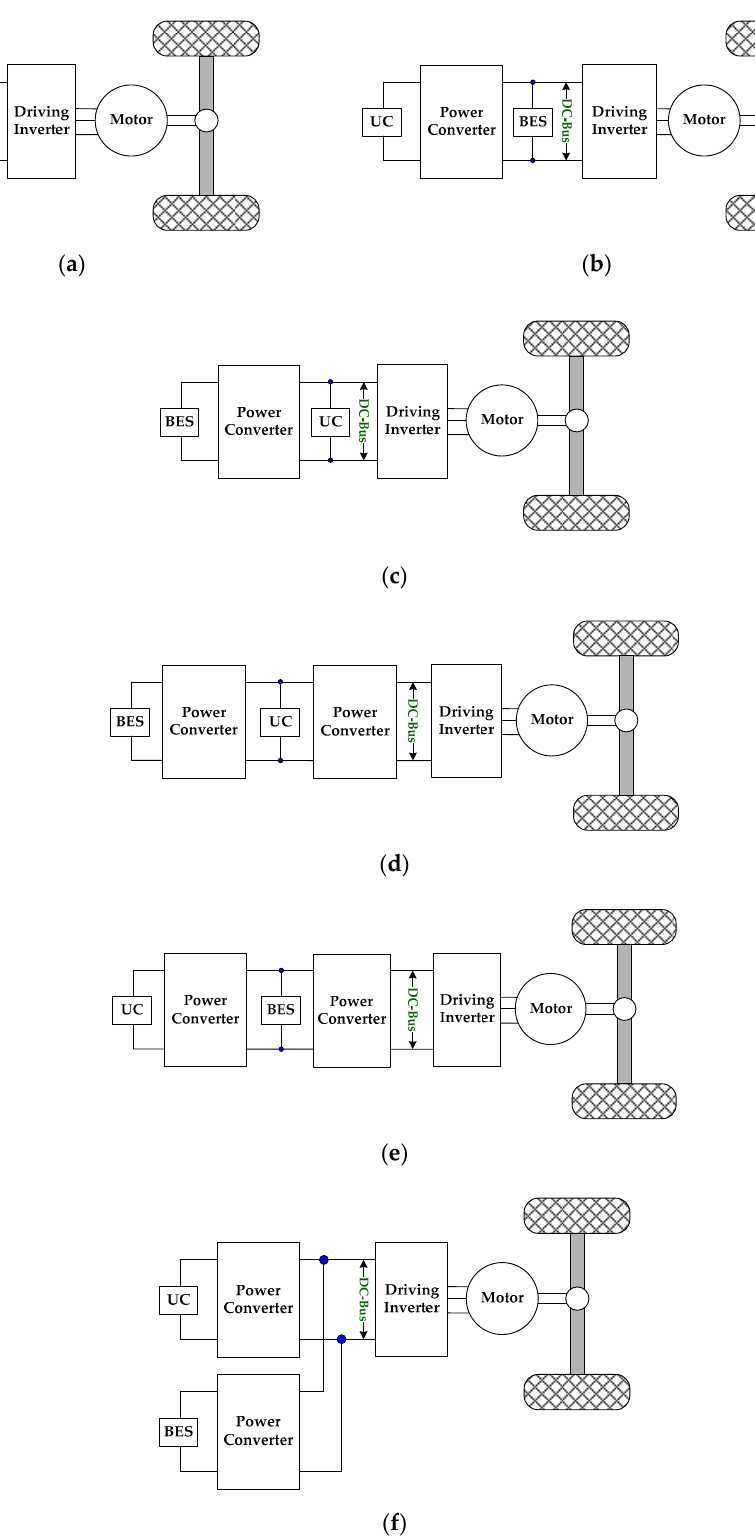
Figure 1. Several schemes of interfacing battery energy storage (BES) and ultracapacitor (UC) to the DC-bus in electric vehicle (EV) power train: ( a ) Directly parallel hybrid scheme; ( b ) UC/BES scheme; ( c ) BES/UC scheme; ( d ) type-I of cascaded scheme; ( e ) type-II of cascaded scheme; ( f ) multiple converter parallel scheme.